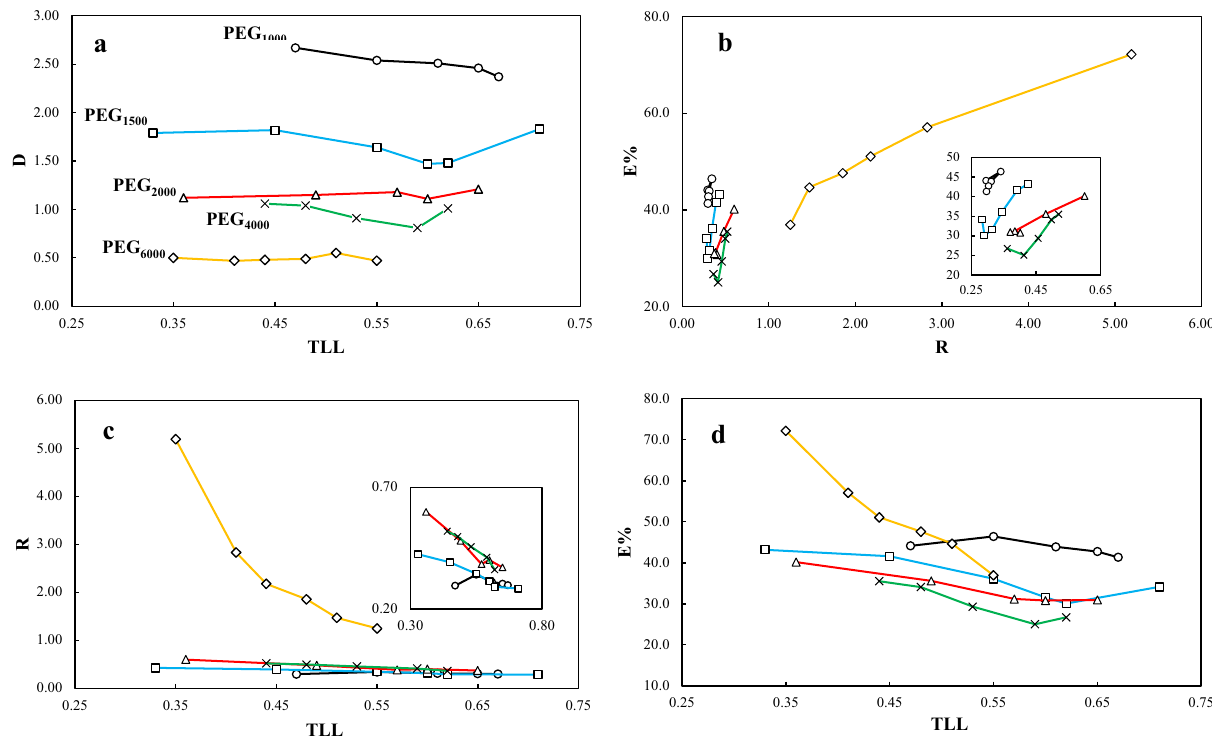
Figures 9. ( a ) Partitioning coefficient ( D ) as a function of tie-line length ( TLL ); ( b ) Extraction efficiency percent ( E %) as a function of separation coefficient ( R ); ( c ) R as a function of TLL; ( d ) E % as a function of TLL; for partitioning of salbutamol in the top and bottom phases of PEG 1000,1500,2000,4000,6000 (1) + trilithium citrate (2) + water (3) at T = 298.15 K, and P = 101 kPa. In these figures, ( ○ ) is for ATPSs of PEG 1000 , ( □ )PEG 1500 , (∆) PEG 2000 , ( ×) PEG 4000 , and (◊) PEG 6000 .